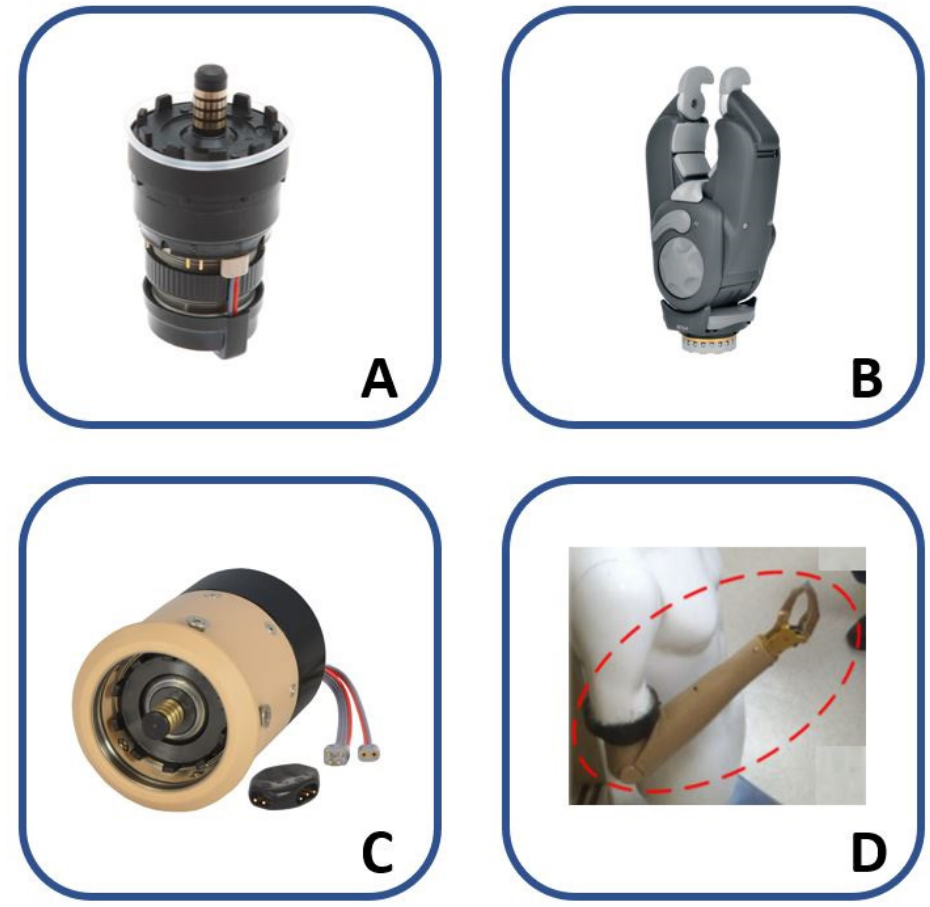
Figure 7. Prosthetic systems used in the analyzed papers on the TMR subjects: ( A ) Wrist rotator (Ottobock) used in [21,24,31,34]—Photo courtesy of Ottobock; ( B ) Greifer Terminal (Ottobock) used in [21,31,34,46]—Photo courtesy of Ottobock; ( C ) Wrist rotator (Motion Control Inc.) used in [42,46]— Photo courtesy of Motion Control, Inc.; ( D ) Danyang Prostheses Co. (Ltd, Danyang City, China) used in [41]— (http://creativecommons.org/licenses/by/4.0/, accessed on 5 March 2021), this image has been cut from